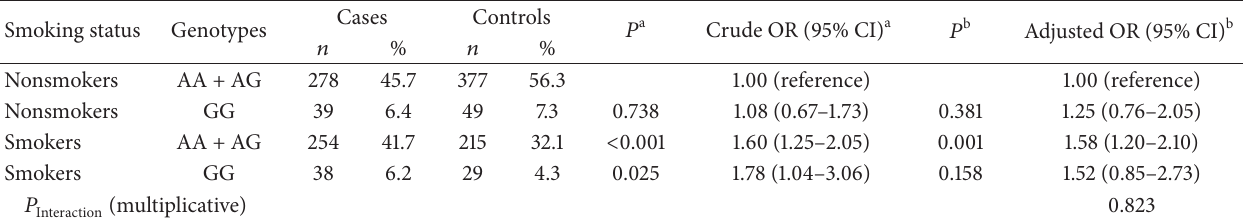
Table 6: Interaction analyses of the TSP-1 -1223 A/G polymorphism and tobacco